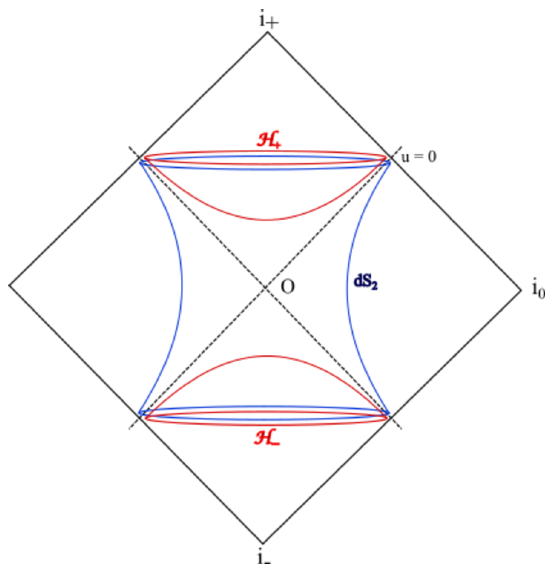
Figure 1 . Penrose diagram of flat space and (A)dS 2 foliations. The H ± slices are at constant timelike separation from the origin O. The dS slices are at constant spacelike 2